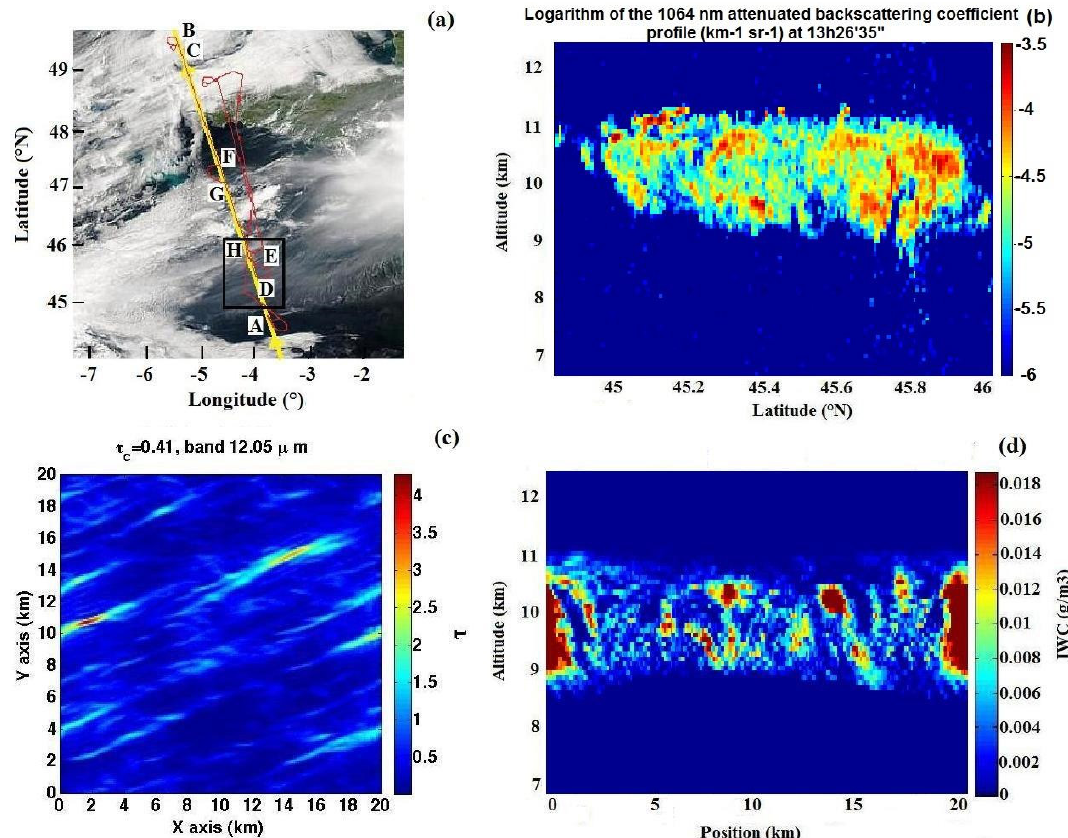
Figure 4. Observed ( (a) , (b) ) and simulated ( (c) , (d) ) cirrus cloud on 25 May, 2007 during the CIRCLE II campaign. (a) shows the MODIS “true color RGB" picture of the cirrus. The bold yellow line represents the CALIOP track and the red line the French Falcon 20 flight. Measurements start from point A to finish at point H. The black rectangle represents the cirrus area without any low-water cloud below. (b) represents the vertical profile of the attenuated backscattering coefficient of the cirrus observed by the lidar CALIOP/CALIPSO inside the black rectangle in (a) . (c) represents the 20km × 20km optical thickness field generated at 12 . 05µm with a horizontal spatial resolution of 100m and with the mean optical thickness τ c = 0 . 41 observed by IIR at 12 . 05µm. (d) represents the x-z view of the cirrus IWC generated by 3DCloud with a vertical resolution of